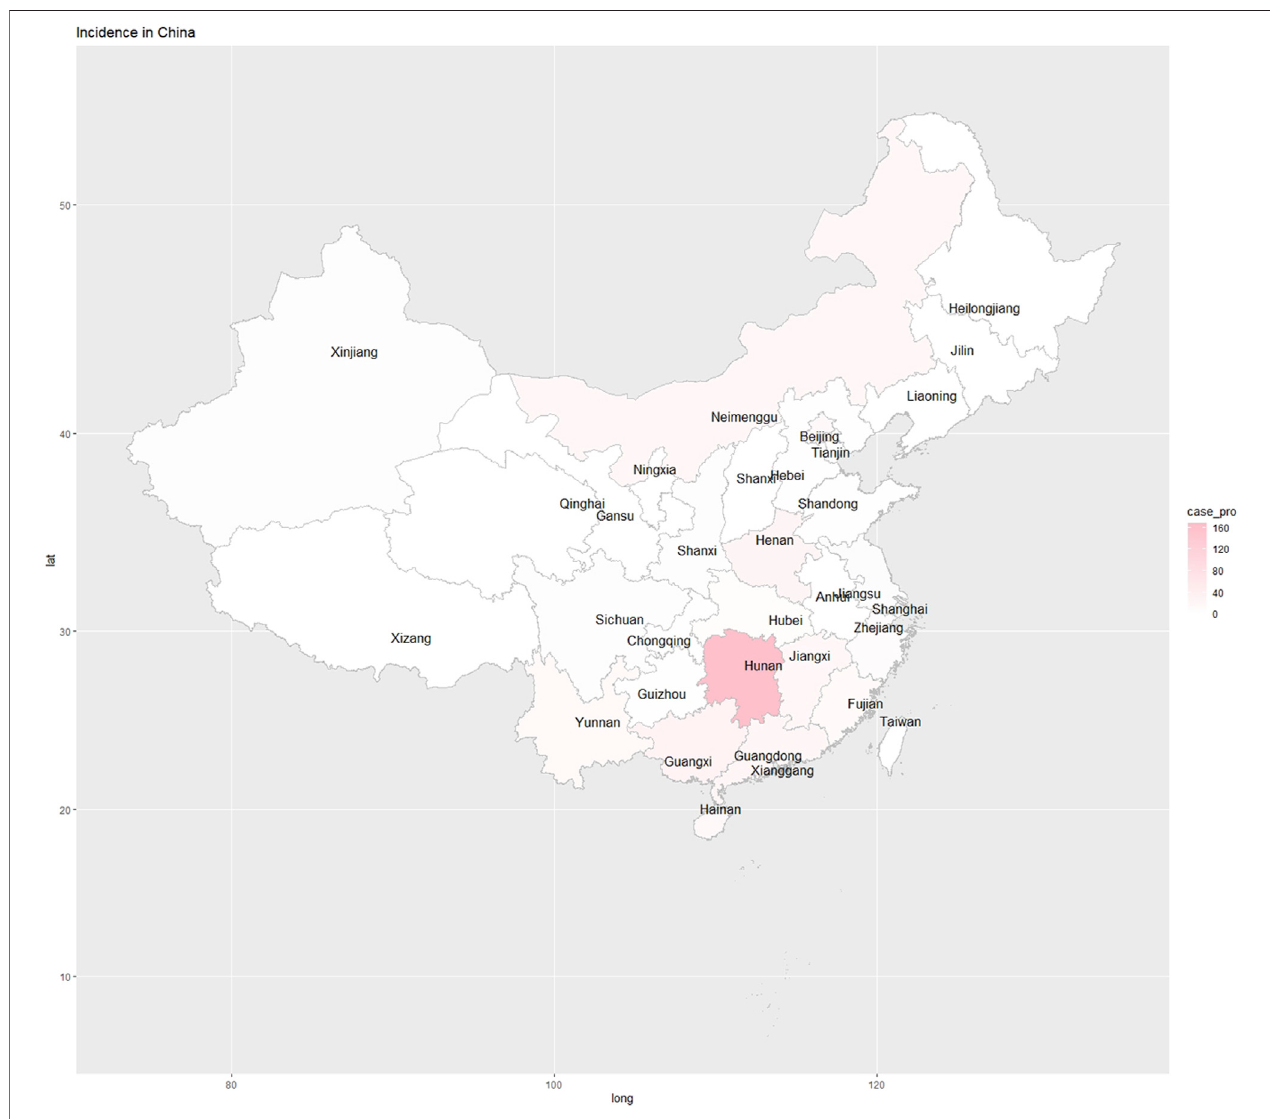
FIGURE 1 | An overall map of PGx participants were from all provinces, municipalities, and autonomous regions.